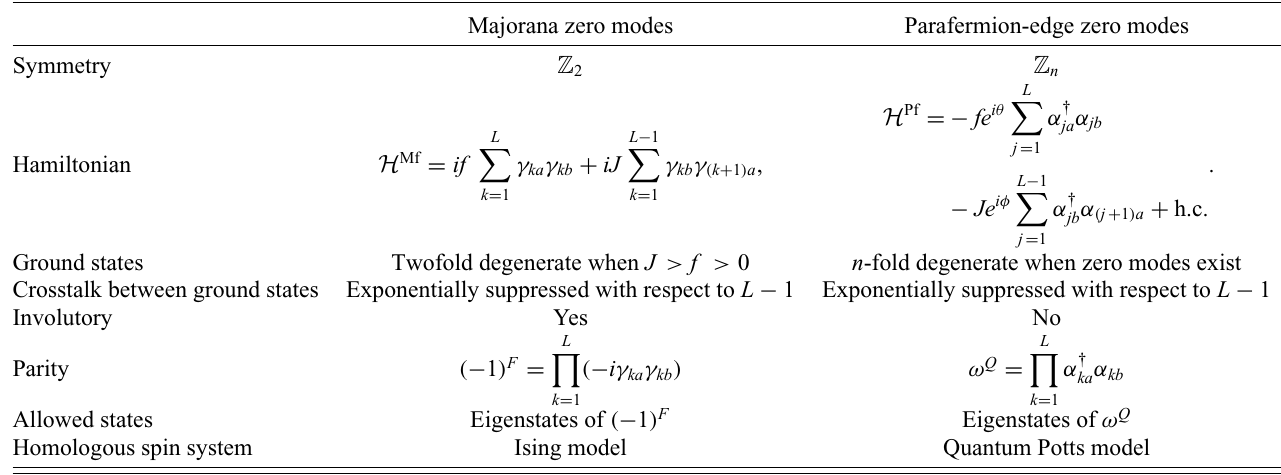
TABLE I. A comparison between Majorana fermions and parafermions. Majorana zero modes Parafermion-edge zero